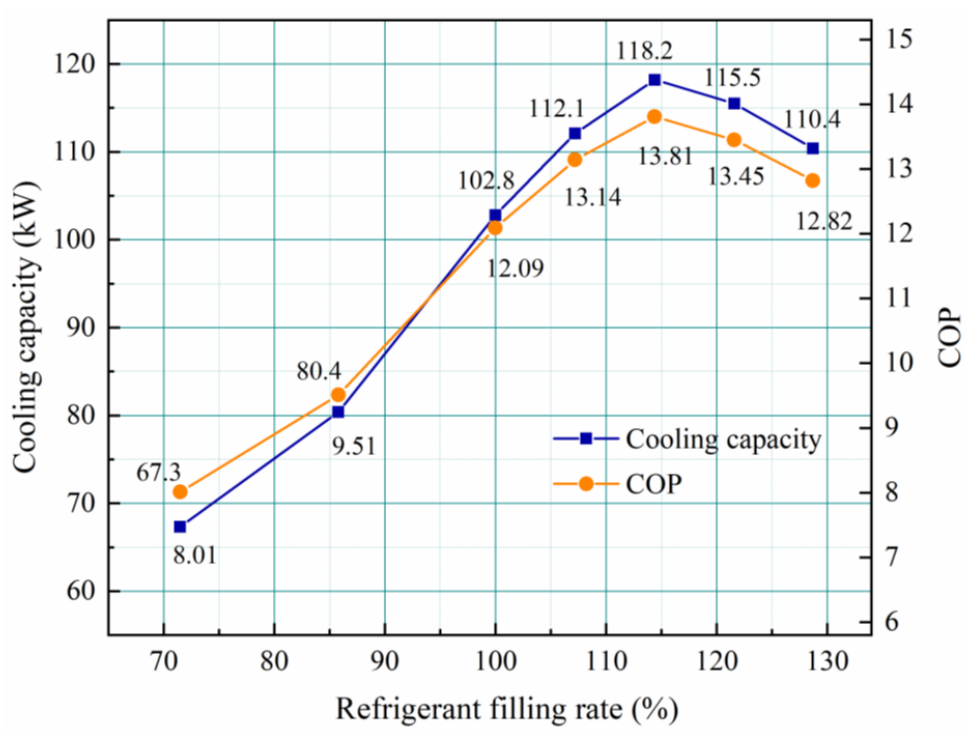
Figure 4. Effect of different liquid-filling rates on the performance of heat pipe system.